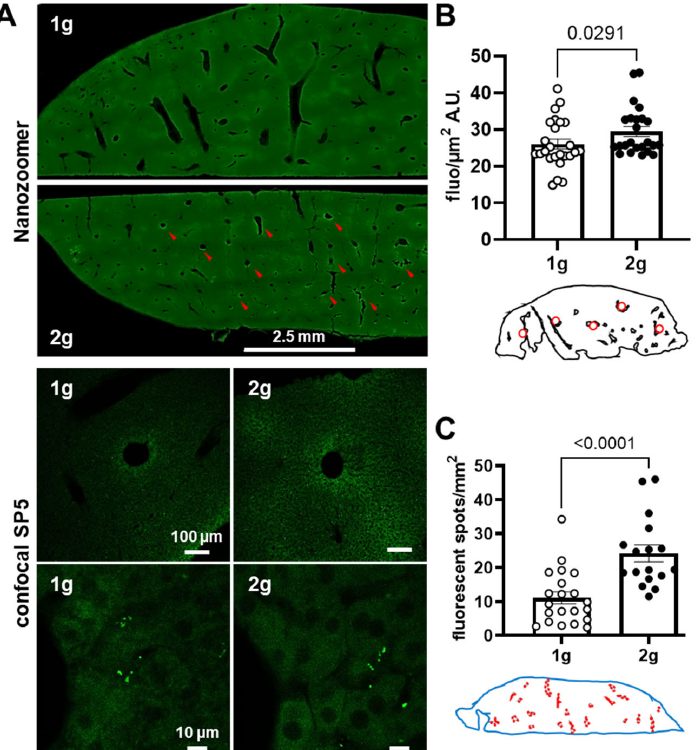
Figure 4. Effects of centrifugation on extravasation of fluorescent AS in liver. ( A ) Typical images of liver slices from mice exposed to normogravity (1 g) and hypergravity (2 g) obtained with Nanozoomer (upper panel) and confocal SP5 (lower panels, with two different magnifications). Red arrows indicate AS fluorescent spots. ( B ) The fluorescent level, expressed as grey level (A.U.) per surface ( µ m 2 ) of the AS in liver (n = 24), was used as an index of extravasation. Red circles on schema of the liver slices represented the ROI used for the analysis. ( C ) Density of fluorescent spots (number of spots per mm 2 ) used as an index of AS inclusion into the liver tissue. The analysis was performed in the whole slice (blue shape) and red circles on the schema indicated the localization of spots. The 1 g and 2 g conditions are associated with white and black points, respectively, and the p values < 0.05 are